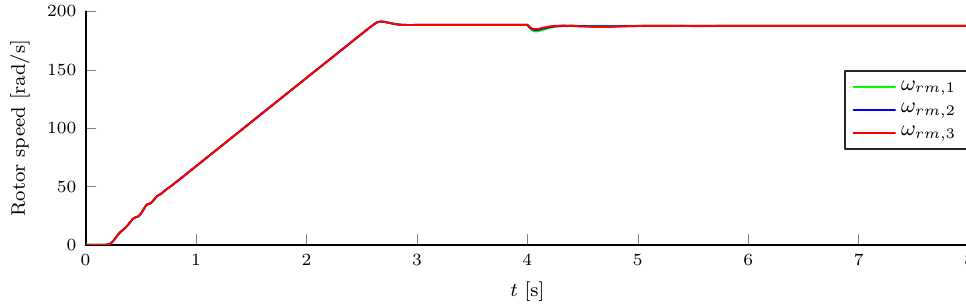
Figure 12. Mechanical rotor velocities including start-up; voltage-source control.